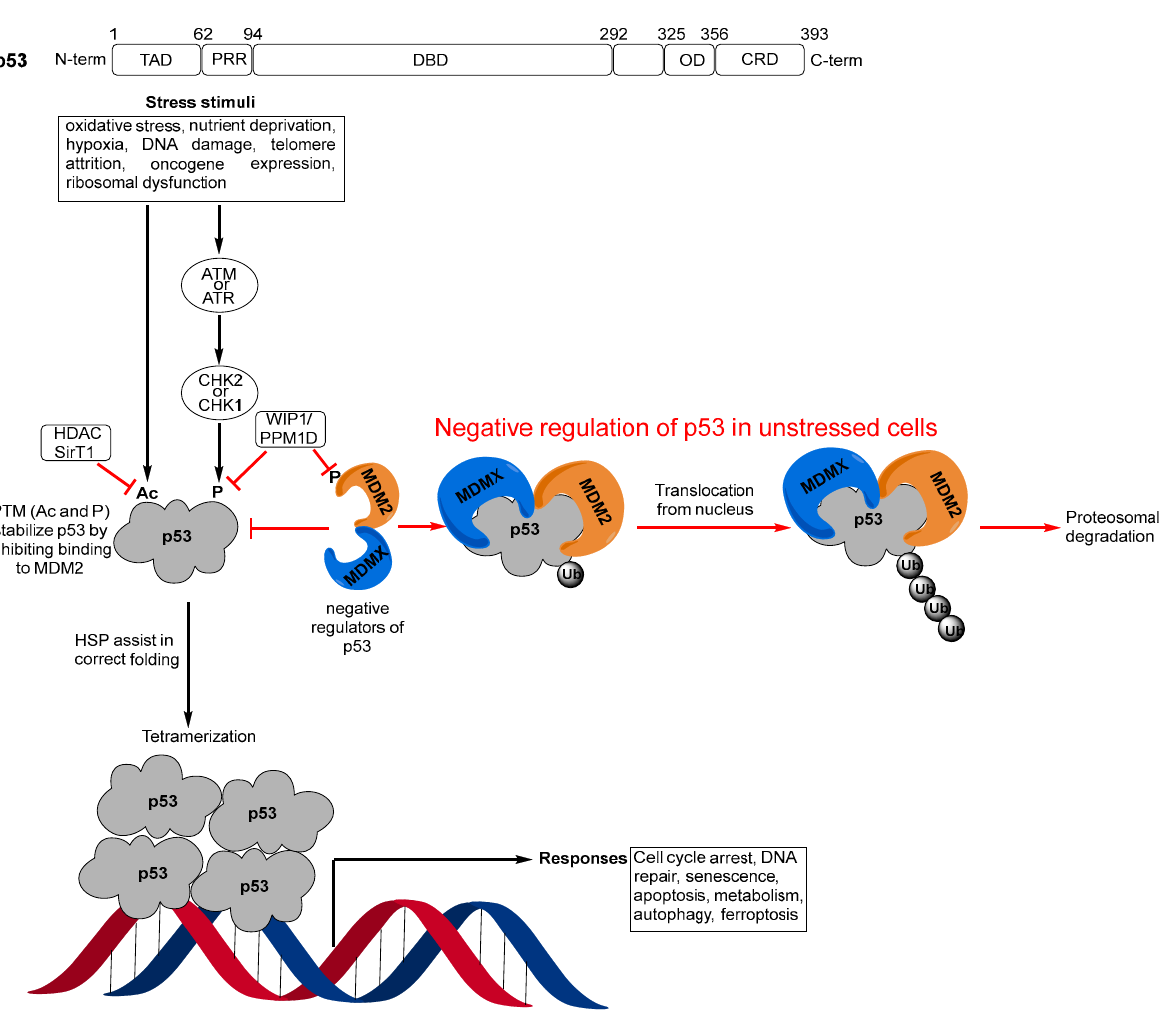
Figure 1. ( p53 domains ) Transactivation domain (TAD), proline rich region (PRR), DNA binding domain (DBD), oligomerization domain (OD), C-terminal regulatory domain (CRD); ( Negative regulation of p53 in unstressed cells ) In unstressed conditions, p53 levels are kept low by binding to its major negative regulators MDM2 and MDMX, which block its transactivation activity and polyubiquitinate it for proteosomal degradation; ( Activation of p53 under stress stimuli ) Under stress stimuli, the post-translational modifications (PTM), acetylation (Ac), or phosphorylation (P) by checkpoint kinase 1 or 2 (CHK1 or CHK2), which result from activation of the upstream kinases ataxia telangiectasia mutated (ATM), and ataxia telangiectasia and Rad3-related protein (ATR), stabilize and activate p53 by inhibiting its binding to MDM2. Heat shock proteins (HSP) then assist in the correct folding of the p53 monomer, which then forms its active tetrameric form, which binds to DNA for gene transcription. In this activation process, there are also other mechanisms that can result in repression of p53 through removal of the PTMs. The histone deacetylase (HDAC), sirtuin 1 (SirT1), deacetylates p53 and enhances its ubiquitination by MDM2. p53 also induces expression of another of its negative regulators, WIP1/PPM1D, which is a phosphatase 1 that destabilizes p53 by dephosphorylating serine 15 in p53 but also by dephosphorylating MDM2, resulting in stabilization of MDM2.